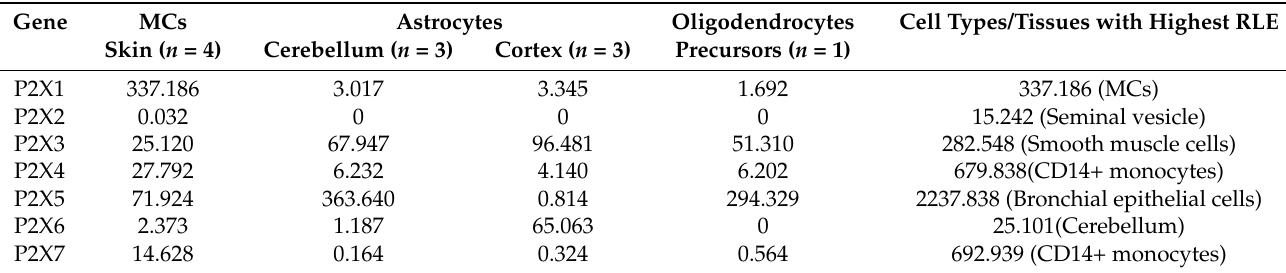
Table 1. Relative logarithmic expression (RLE) of P2XRs in MCs, astrocytes, and oligodendrocytes. P2XR RLE expression in skin MCs [142], cerebellum and cortex astrocyte and oligodendrocyte precursors [143] was obtained using Fantom 5 and compared to cell types with the highest RLE for a given receptor.